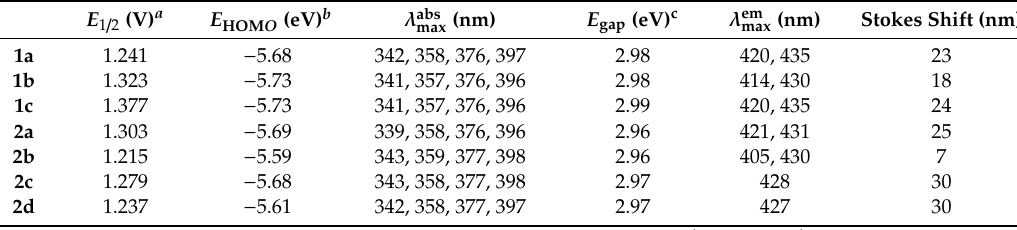
Table 1. Electrochemical and optical characterization of compounds 1a-c and 2a-d.